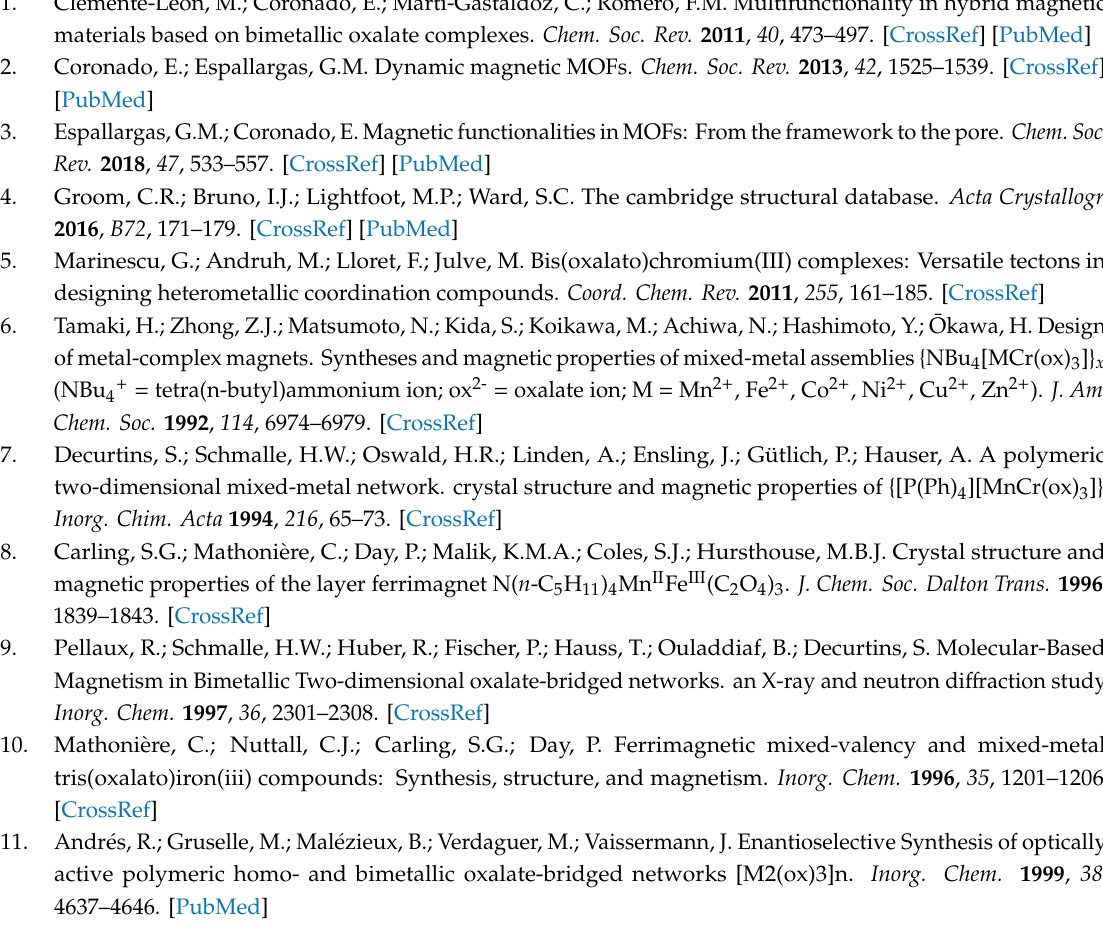
Figure S2: ORTEP-3 diagram of (a) dimeric unit Cu1–Cu2 , (b) 1D chain Cr1–Cu3 and (c) 1D chain Cr2–Cu4 in compound 2 with atom numbering scheme. Displacement ellipsoids are drawn for the probability of 50% and hydrogen atoms are shown as spheres of arbitrary radii, Figure S3: ORTEP-3 diagram of asymmetric unit of compound 3 with atom numbering scheme (uncoordinated water and acetonitrile molecules have been omitted for clarity). Displacement ellipsoids are drawn for the probability of 50% and hydrogen atoms are shown as spheres of arbitrary radii, Figure S4: Underlying graph with dia topology in coordination polymer 3 . Nodes represent Ca atoms, Figure S5: The thermogravimetric analysis (TG) and di ff erential thermal analysis (DTA) curves for compounds 1 – 3 measured in nitrogen